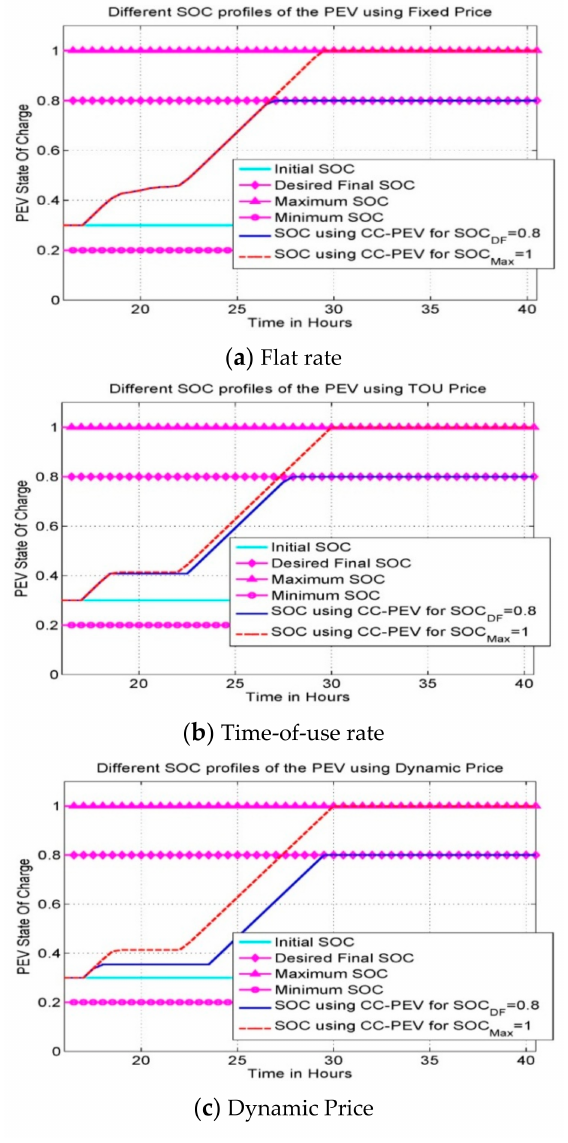
Figure 3. SOC of the Battery for SOC Max = 1 and SOC D = 0.8, for ( a ) Flat rate, ( b ) TOU, ( c ) Dy- namic